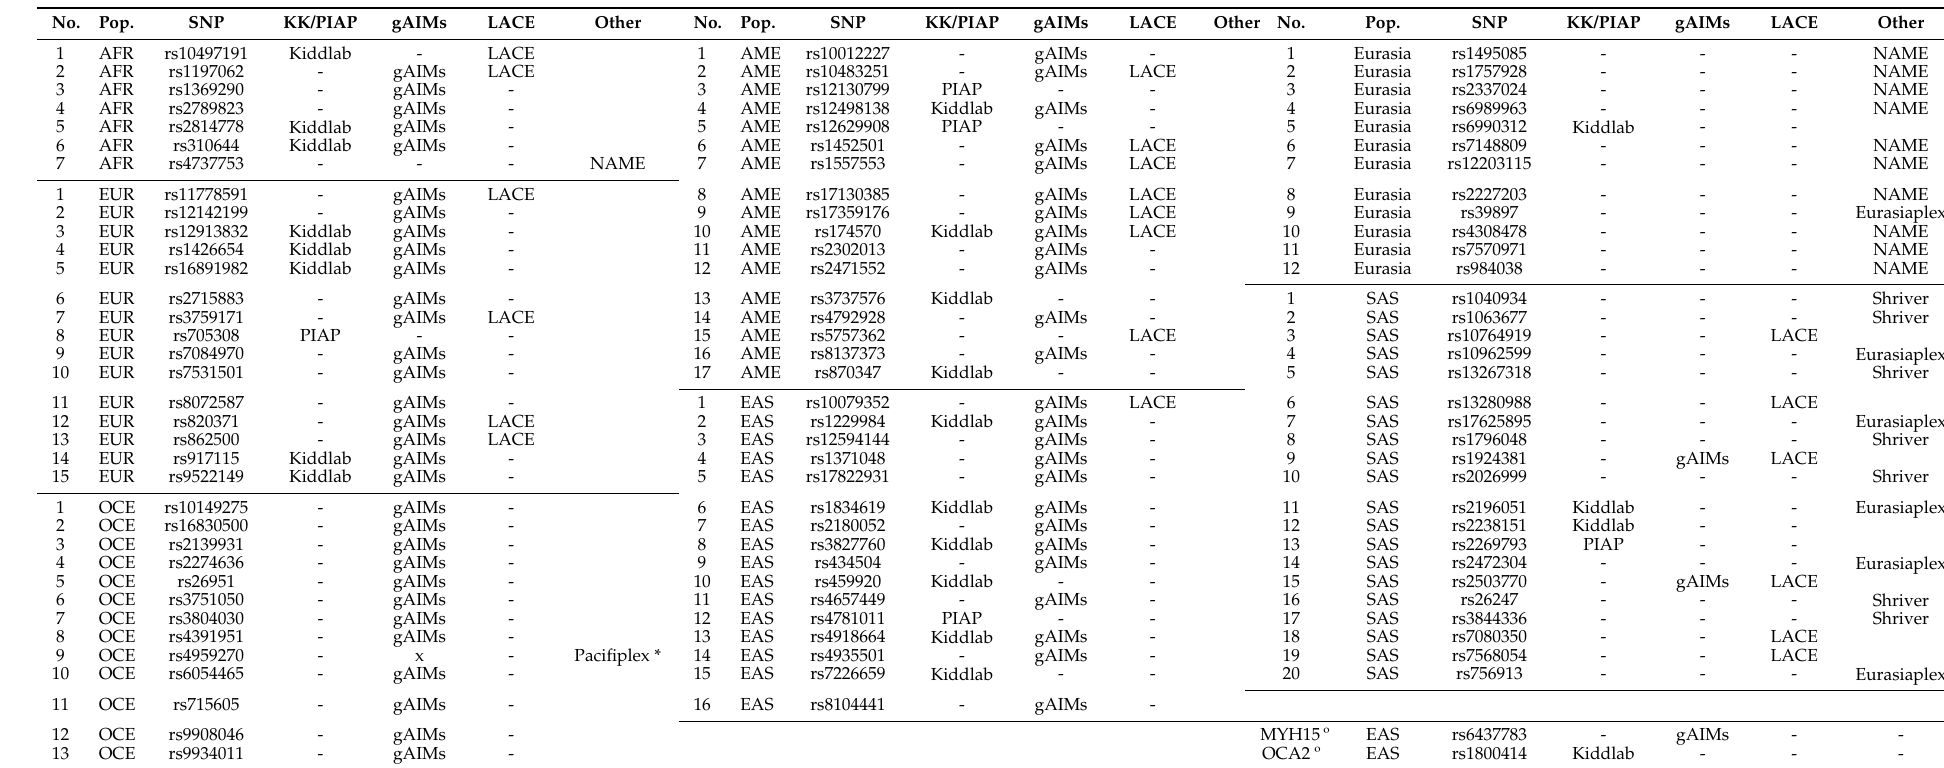
Table 1. Commonality between SNPs selected for the BT ancestry panel and established forensic ancestry panels: Kiddlab 56; Thermo Fisher Precision ID Ancestry Panel (PIAP); Euroforgen Global AIMs (gAIMs); the LACE panel; the NAME panel; Eurasiaplex; and Shriver et al. US admixture mapping panel [24]. The two markers lower right are BT appearance SNPs previously selected as